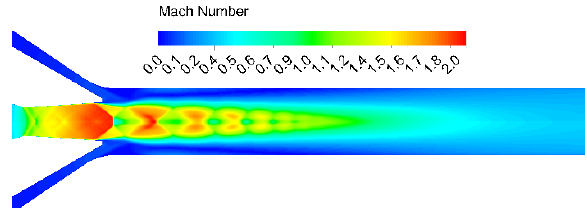
Fig. 11. Contours of Mach number for relative back-pressure p 4 /p 02 = 1.62 (157 kPa